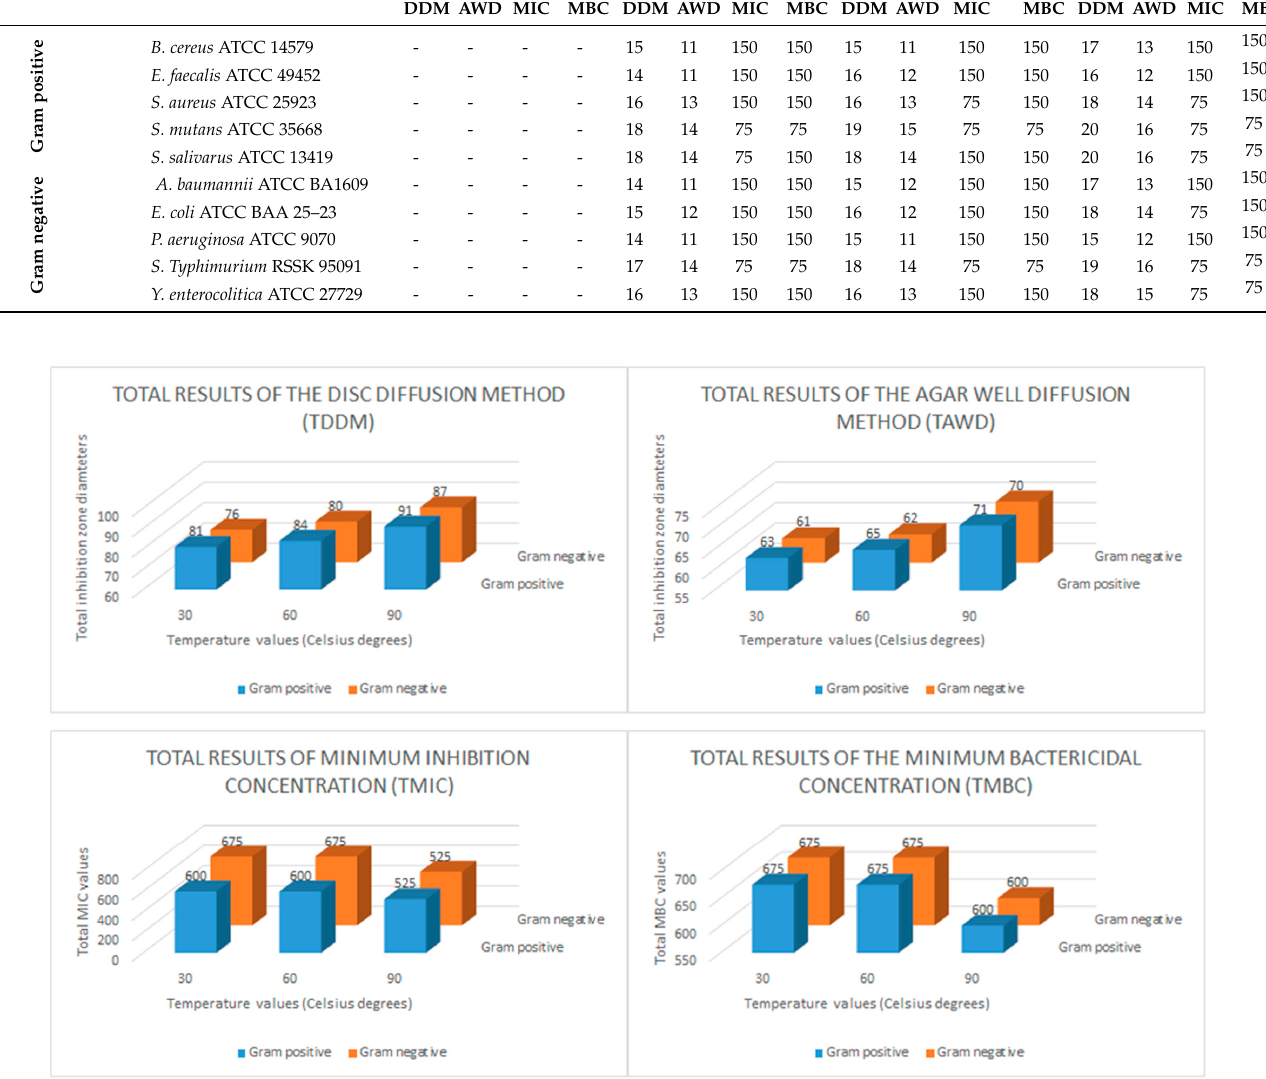
Figure 5. Bar graph of the in vitro antibacterial activity of the chestnut honey-based silver nanoparticles (CH-AgNPs). Total results of the disc diffusion method (TDDM: mm), total results of the agar well diffusion method (TAWD: mm), total results of the minimum inhibition concentrations (TMIC: µ g/mL) and total results of the minimum bactericidal concentration (TMBC: µ